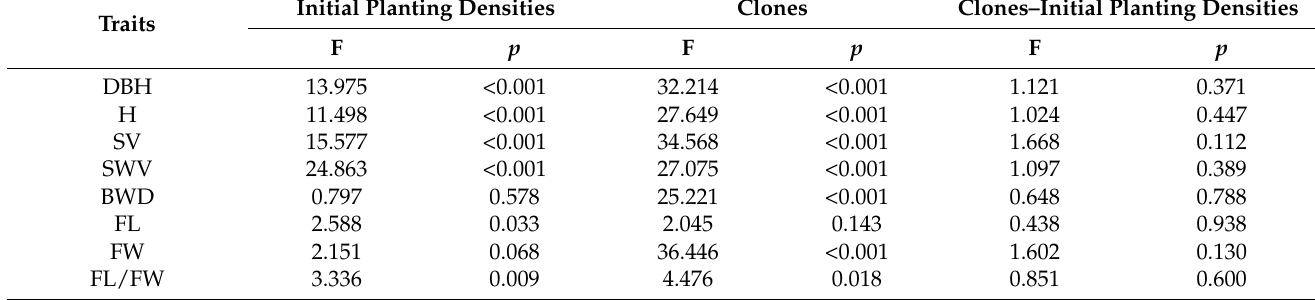
Table 3. Analyses of variance of growth traits, BWD, and fiber properties of 11-year-old triploid Chinese white poplar at seven planting densities combined.